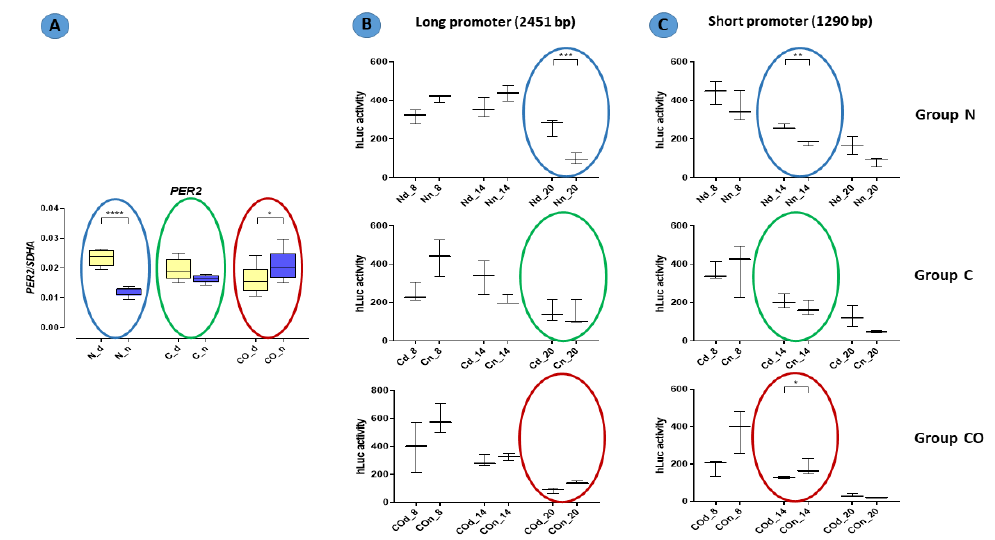
Figure 7. Promoter activity in the normal (N), control (C) and CO-treated groups. The significant differences between day (Nd, Cd, COd) and night (Nn, Cn, COn) were analyzed in each studied group. In functional assay with the HEK 293 cell line, promoter activity was measured with relative luminescence values in 6 h intervals (8 a.m., 2 p.m., 8 p.m.). Oscillation in promoter activity was observed in both the long ( B ) and short ( C ) promoter sequences. Colored circles mark the time points corresponding to the pattern expression obtained in qPCR ( A ) (repeated Figure 1). The asterisks indicate significant differences as follows: *— p < 0.05; **— p < 0.01; ***— p < 0.001; ****— p <